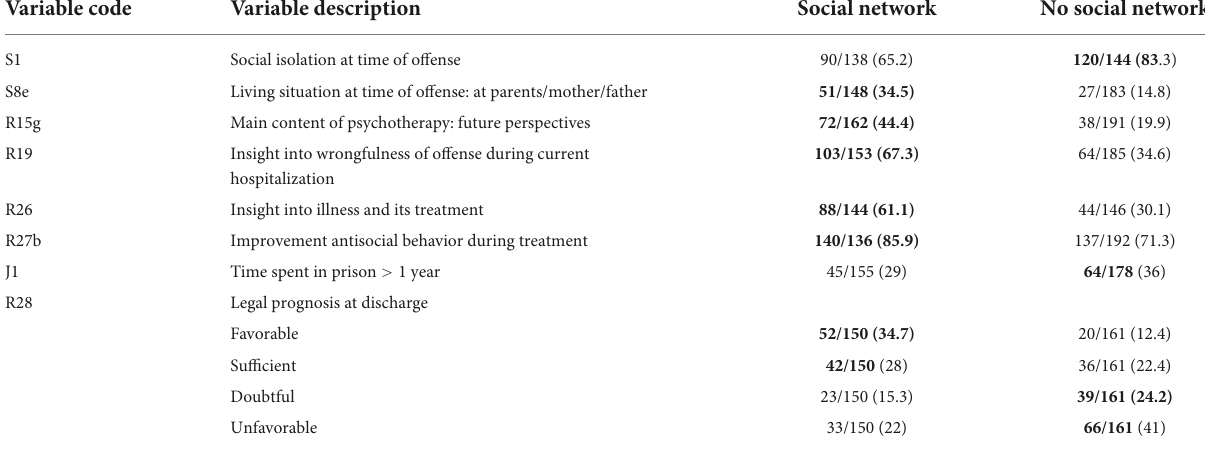
TABLE 3 Absolut and relative distribution of relevant predictor variables.